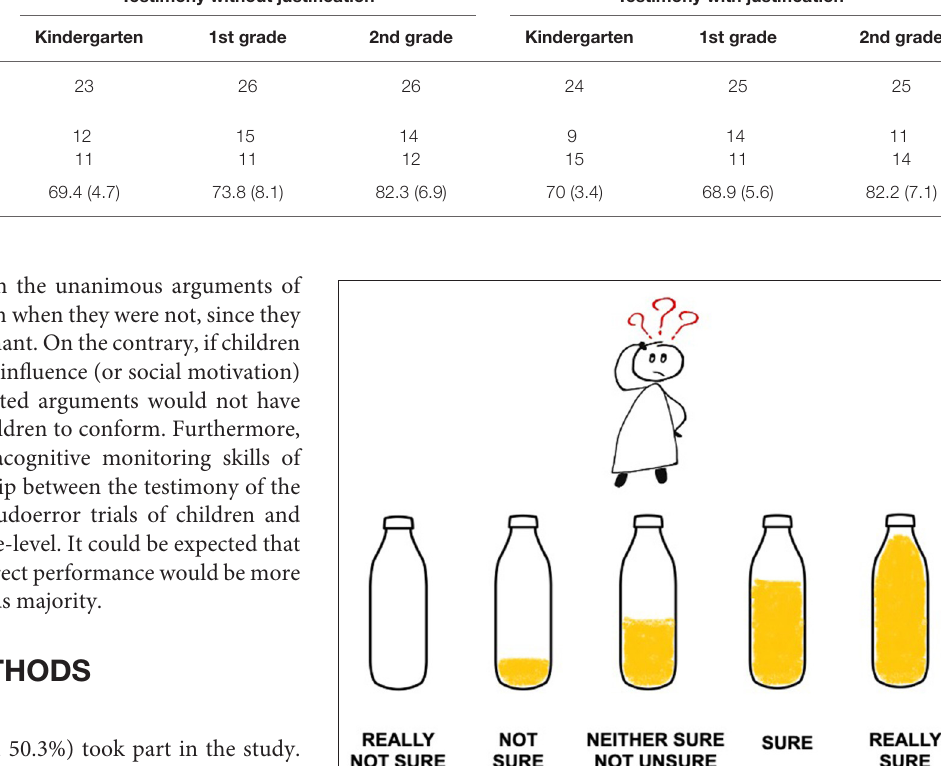
TABLE 1 | Sample characteristics as a function of each experimental condition of the testimony of teachers. Characteristics